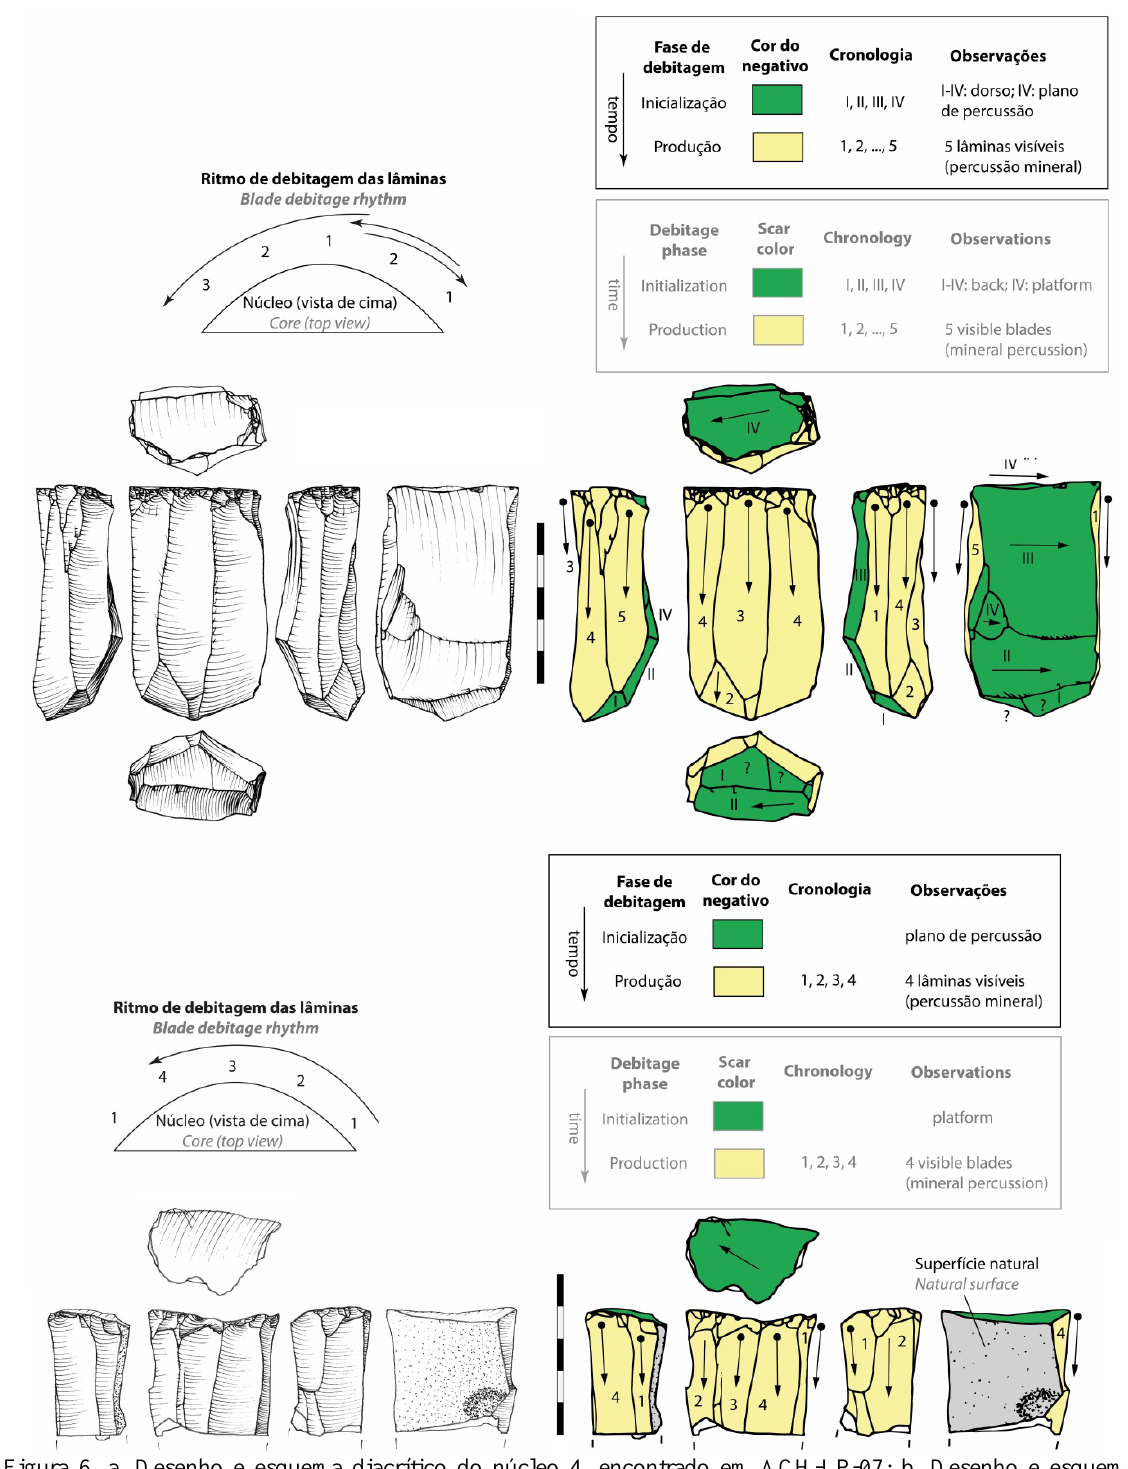
Figura 6. a. Desenho e esquema diacrítico do núcleo 4, encontrado em ACH-LP-07; b. Desenho e esquema diacrítico do núcleo 5, encontrado em RS-URG-01. Figure 6. a. Drawing and diacritic scheme of core 4, from ACH-LP-07; b. Drawing and diacritic scheme of core 5, from